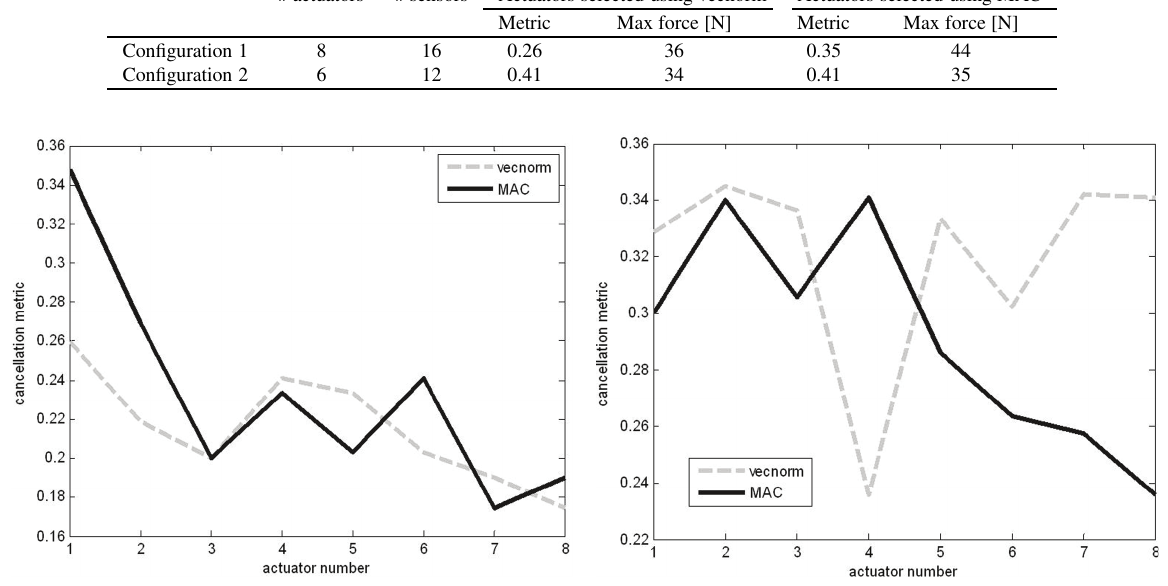
Fig. 4. Performance metric comparison of the top 8 actuator positions using the vector normalization and MAC approaches with error sensors in region 2 (main acoustic cavity).